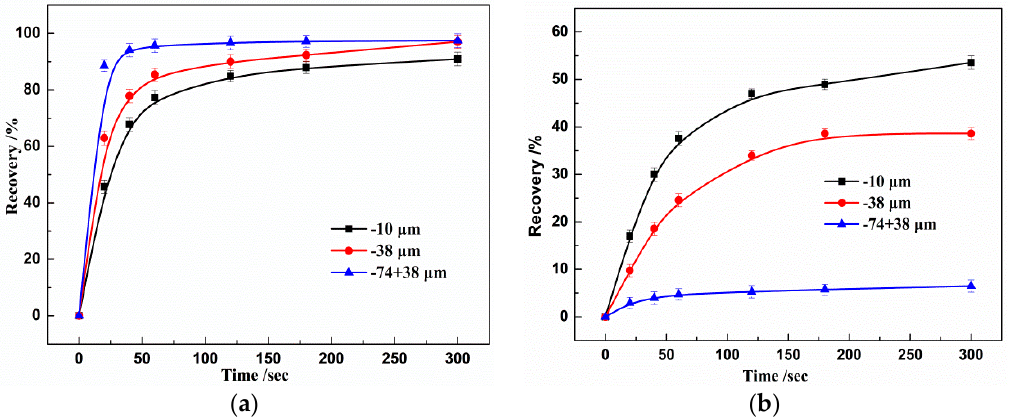
Figure 5. Accumulative recovery results for different size fractions ( a ) in the absence and ( b ) presence of galactomannan (FPY). Table 3. Calculated model parameters for the three size fractions of talc.